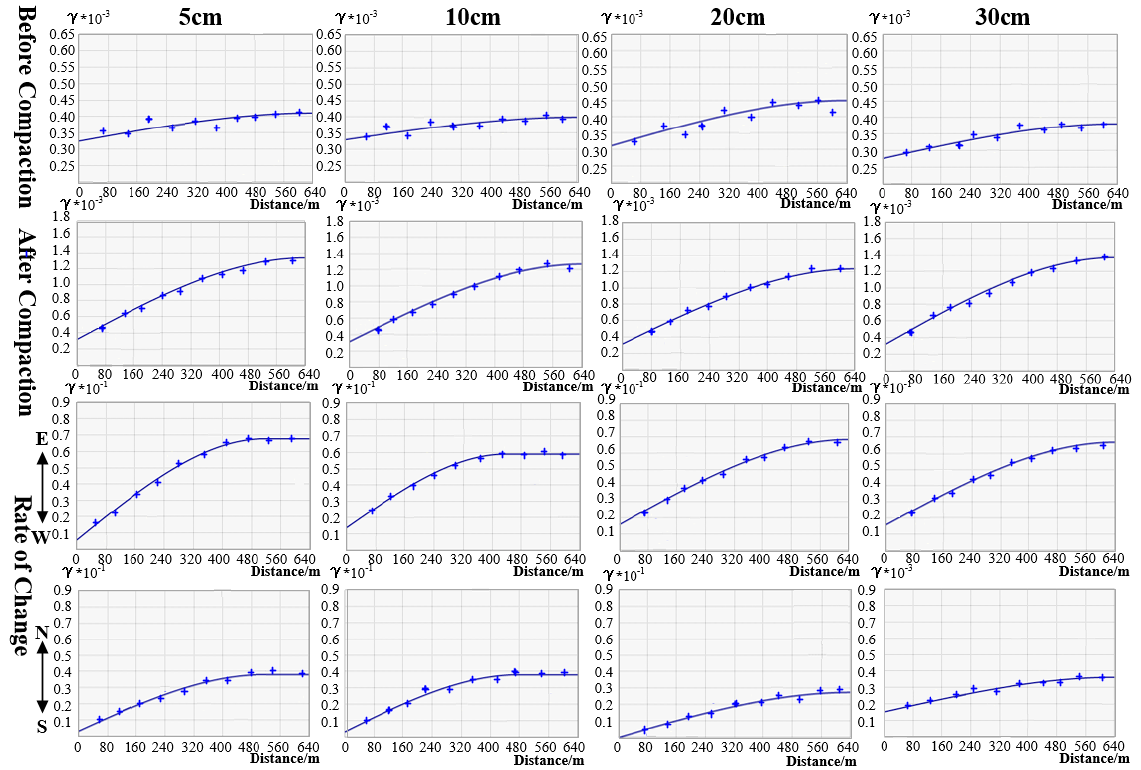
Figure 13. Transverse spatial semi − variance functions of soil porosity at various depths before and after compaction.